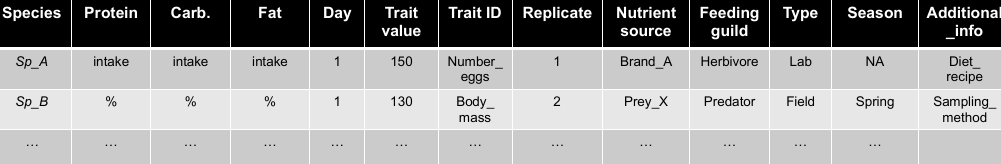
Figure 1. Overview of the geometric framework for nutrition (GFN). ( A ) Schematic representation of the performance landscape plotted in a two-dimensional nutrient space (here defined by protein (P) and carbohydrate (C) intake). Nutritional rails are diets with varying PC ratios. Red dots represent the concentrations of the different diets. The ‘width’ of the landscape is determined by the nutritional rails. The ‘length’ of the landscape is determined both by the concentrations within each rail and the individual variation in nutrient intake within each rail. ( B ) Empirical performance landscape (i.e., lifespan) from a GFN study in Drosophila melanogaster (extracted from [7]). ( C ) Schematic representation of the Right-Angle Mixture Triangle (RMT) used to assess diet mixtures primarily in field studies. Note that the % of carbohydrate in the mixture increases as the axis moves towards the origin (solid arrow) so that the mixture is constrained within the limits delimited by the dashed isocline. ( D ) Empirical Right-Angle Mixture Triangle (i.e., milk composition) from a field study (extracted from [12]). ( E ) Template for storing and sharing GFN data. An Excel (.csv) version is provided in Appendix A.